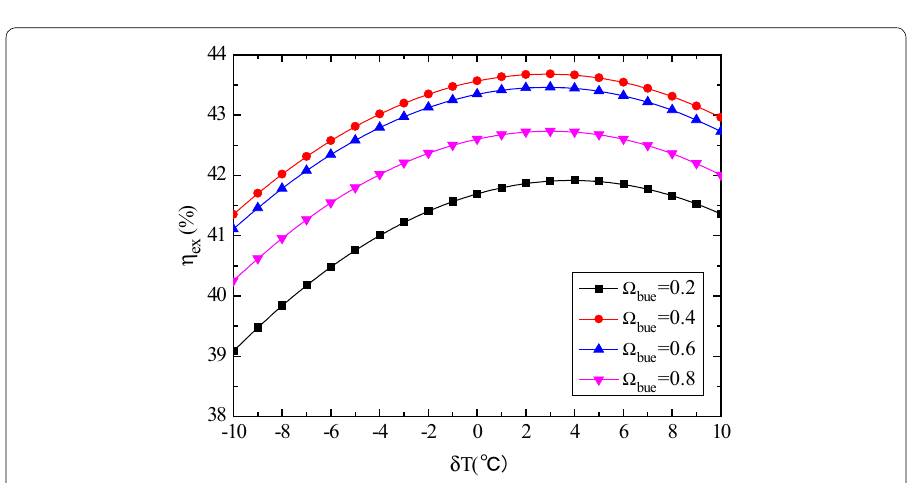
Fig. 12 η ex versus δT with different Ω